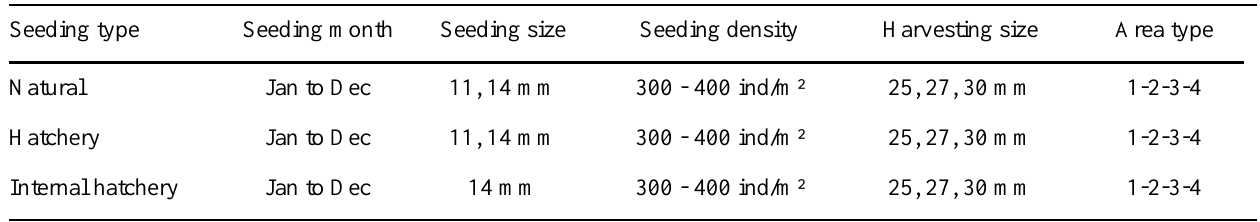
Table 5. Parameters taken into consideration in the definition of the scenarios. Seeding